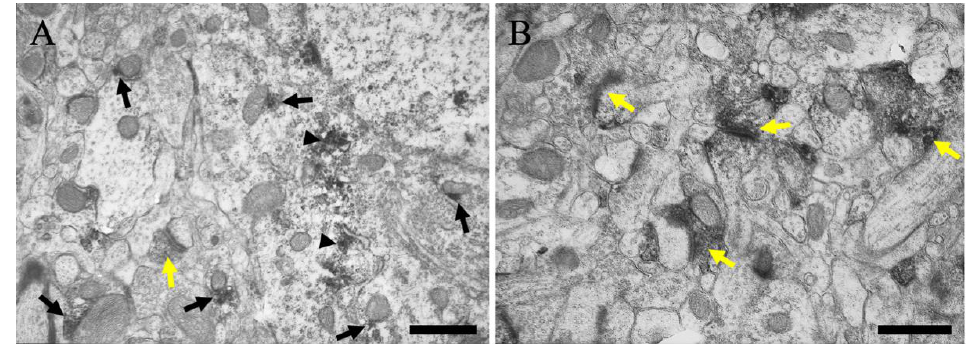
Figure 5. Immunoelectron microscopic views of layer V of the cerebral cortex are shown. ( A ) The neuron and neuropil near the neuronal soma are presented. ( B ) The neuropil far from the neuronal soma is presented. Black arrows indicate MGRN1 immunoreactivity near the mitochondria. Black arrowheads indicate MGRN1 immunoreactivity near the subcellular organelles without mitochondria; e.g., endoplasmic reticulum. Yellow arrows indicate MGRN1 immunoreactivity in the pre-synapses. Scale bars = 500 µ